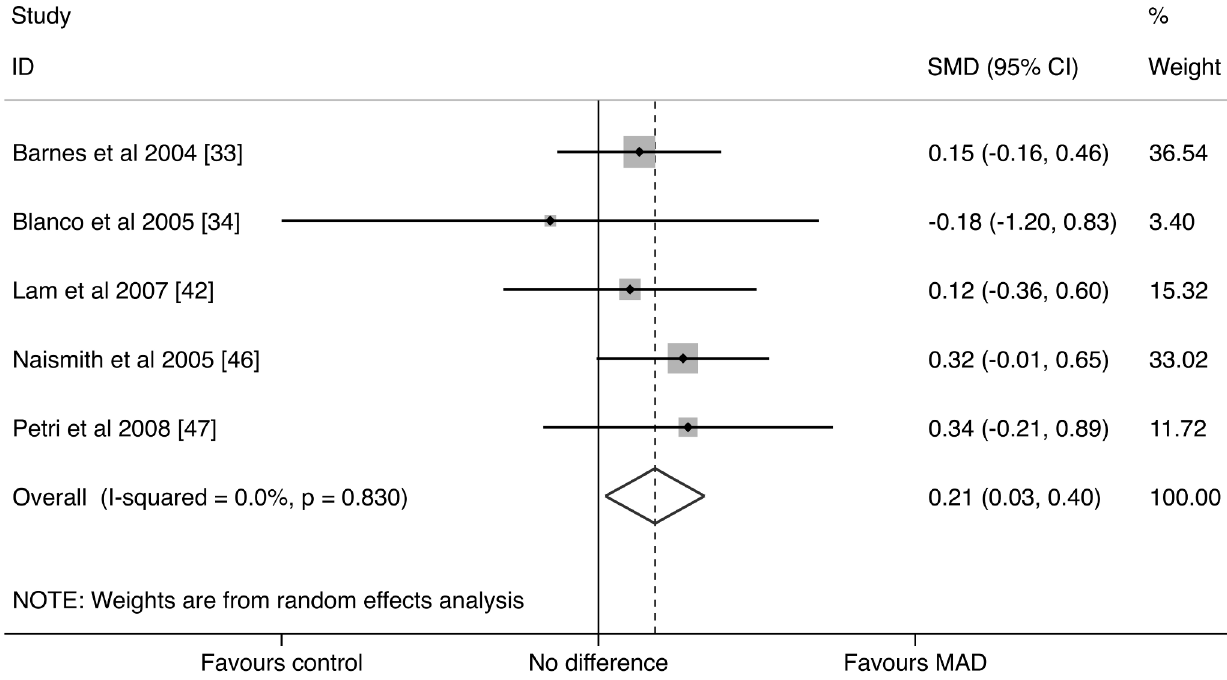
Figure 3. MAD studies forest plot. Data were calculated by a random effects model. Boxes are SMDs, and lines are 95% CIs. The vertical solid line represents no difference between MAD and control. Values to the right of the solid line favor MAD benefit. Pooled SMD and 95% CI is represented by the diamond shape.